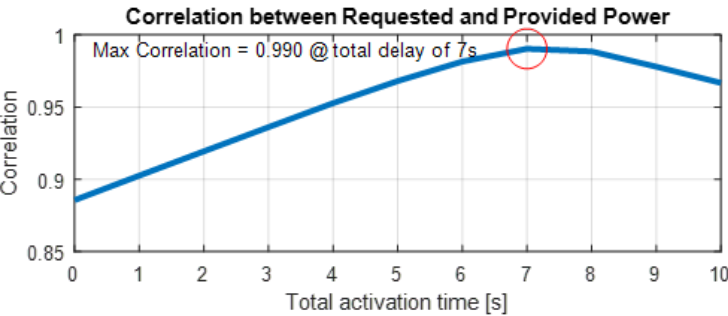
Figure 8. The correlation between requested and provided power for remote control shows a maximum for a delay of 7 s, which can then be considered the total activation time when the tested V2G equipment is controlled via the centralized remote control